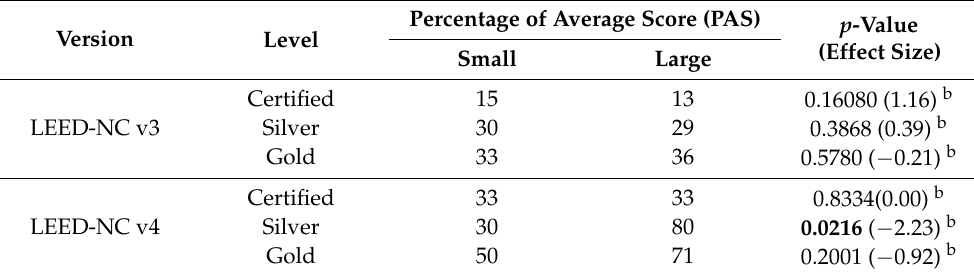
Table 13. LEED-NC v3/v4 office-type projects, operational energy metering